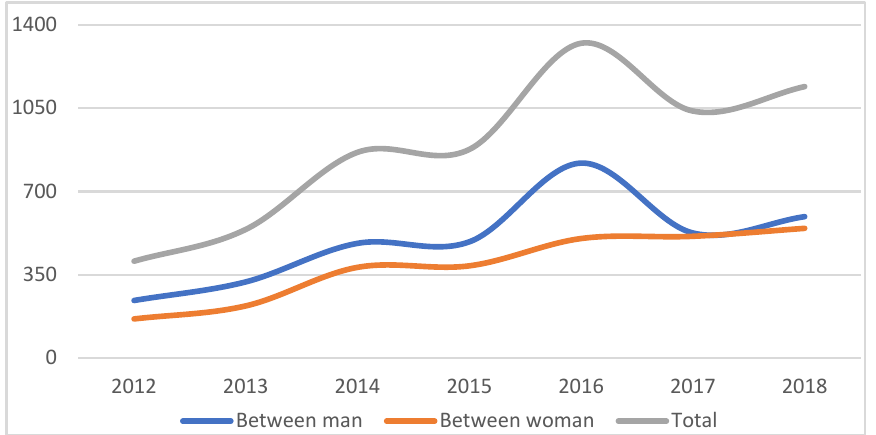
Figure 3. Evolution of divorce in same-sex marriages in Spain, period 2012–2018 (thousands). Source: created by the authors based on data from the ENSD.